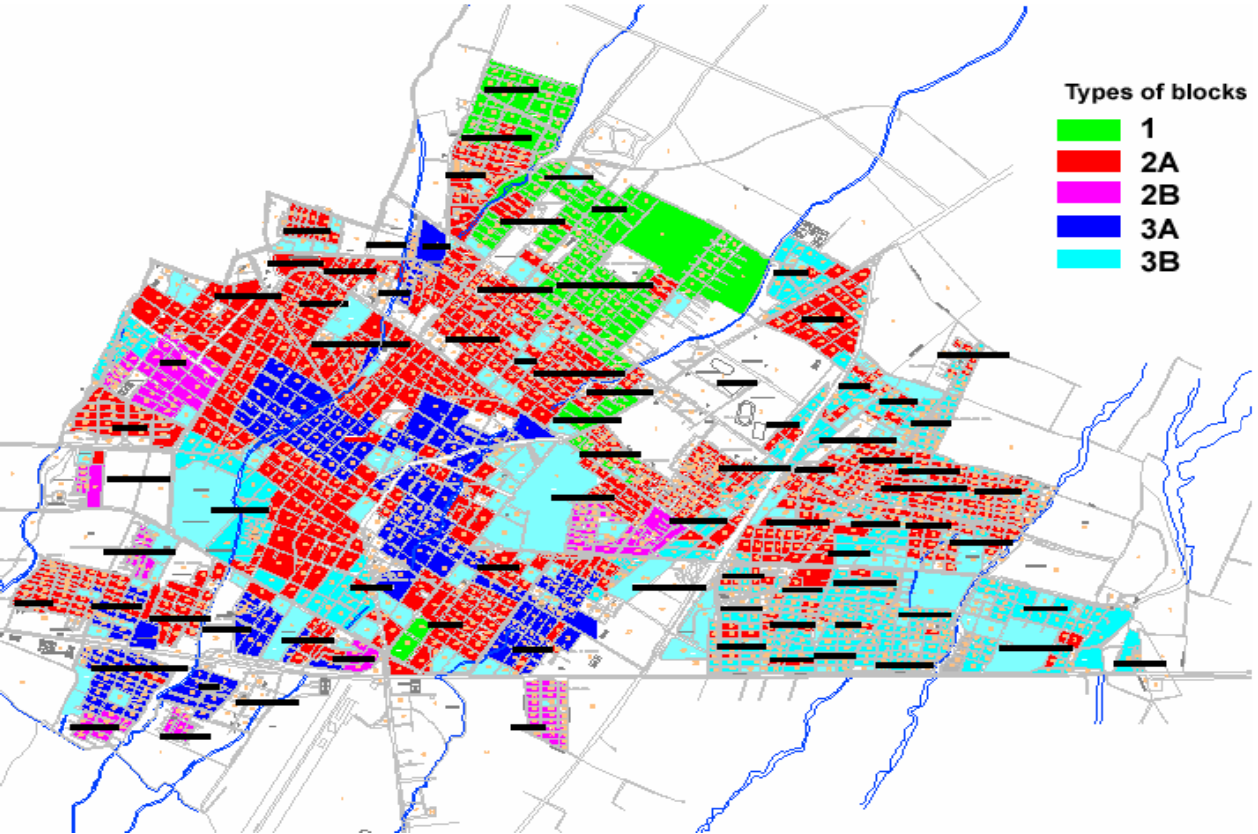
Fig. 9. Zonation of the different types of residential blocks in Colima. The residential blocks are shown by green (type 1), red (type 2a), violet (type 2b), blue (type 3a) and cyan (type 3b) colors. The white zones show the commercial centers and federal